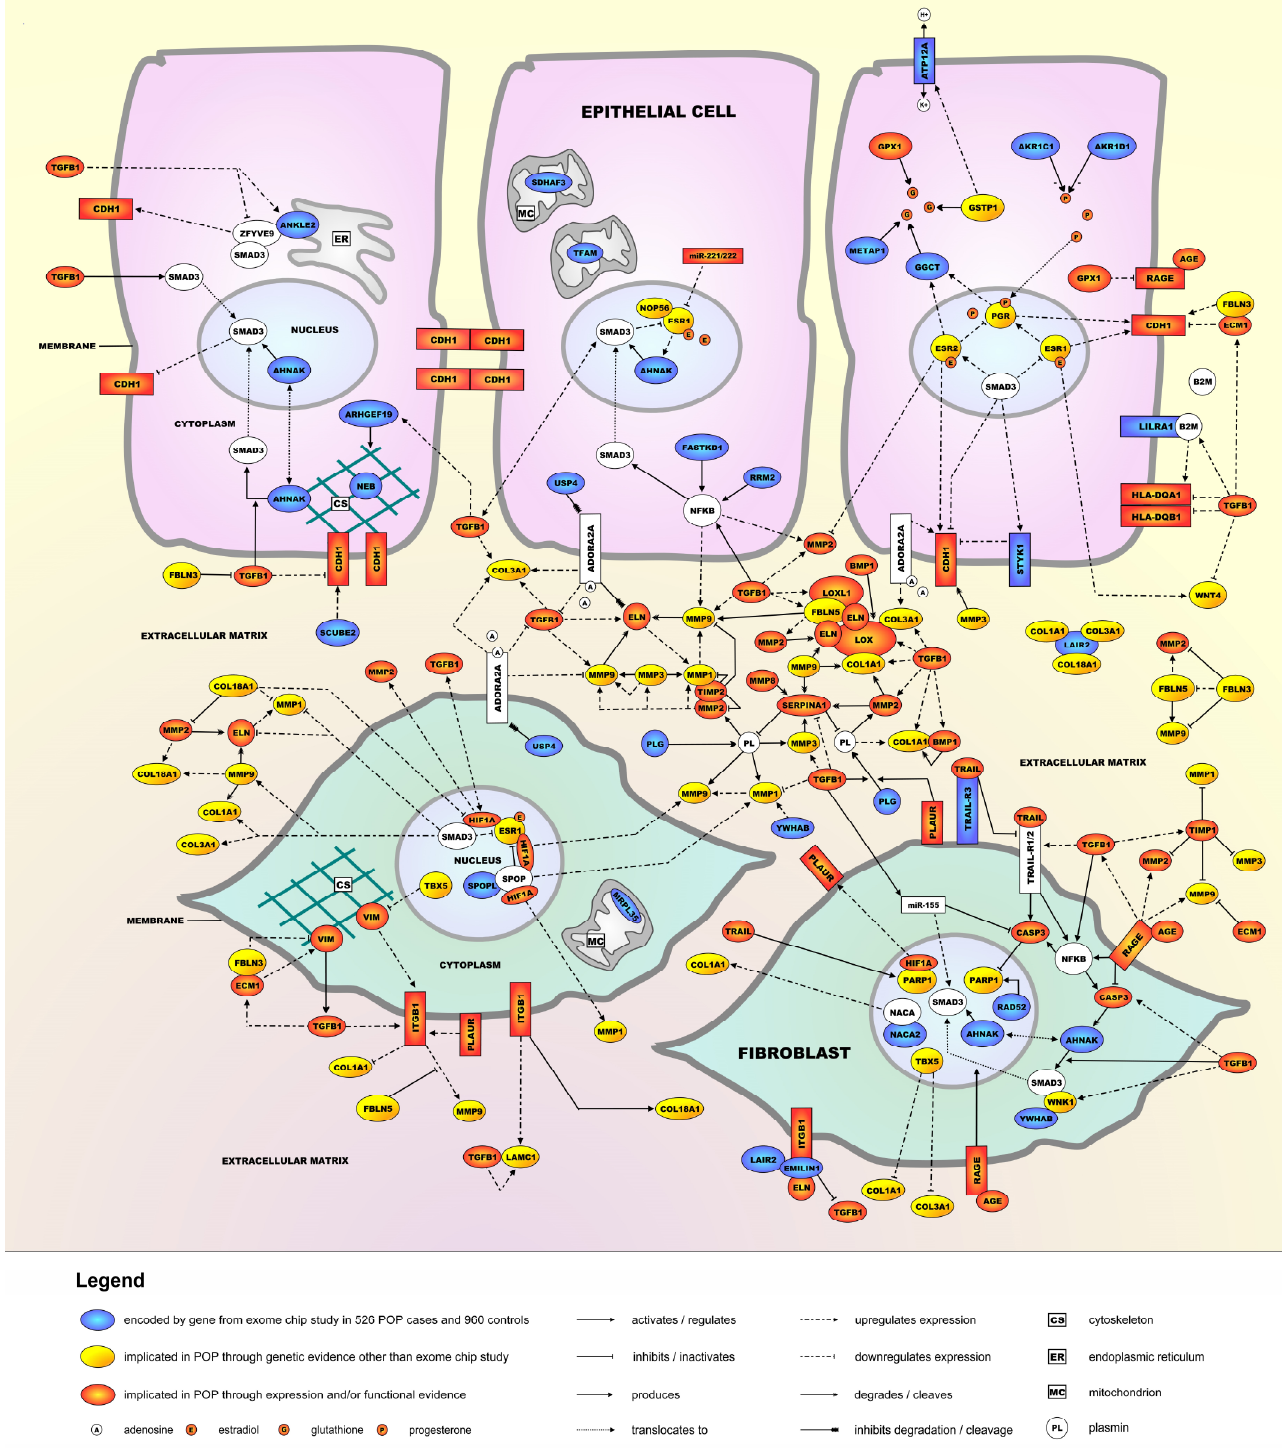
Figure 1. Molecular landscape of pelvic organ prolapse (POP). The POP landscape is located in and around epithelial cells and fibroblasts of the female urogenital tract. Four main biological processes operate in the landscape: (1) The first and most important process in the landscape is EMT. Under normal conditions, epithelial cells are connected to their environment through cell-cell interactions as well as cell-ECM interactions. Among the cell-cell interactions are epithelial cadherin (E-cadherin/CDH1)-based adherens junctions that stabilize epithelial cell-cell adhesion. EMT is characterized by a ‘cadherin switch’, which is initiated when epithelial cells start producing less CDH1 and more of the mesenchymal marker N-cadherin (CDH2) (not shown). This results in loss of epithelial